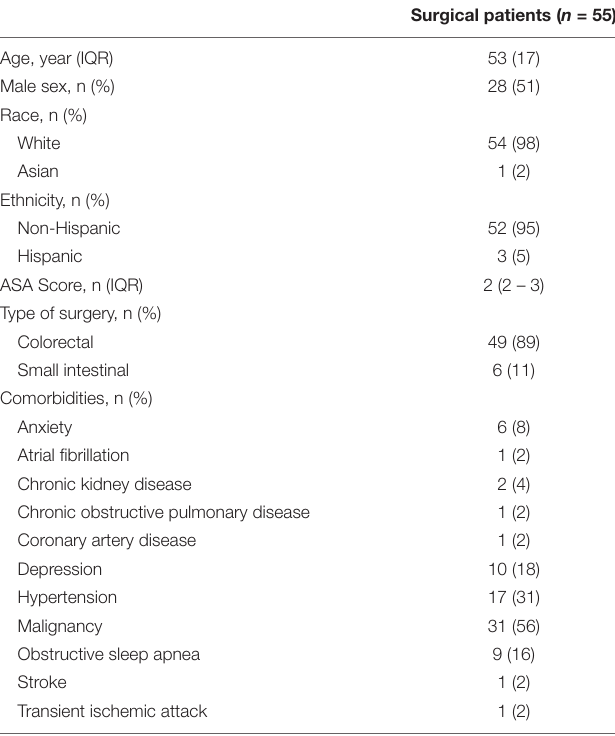
TABLE 1 | Participant characteristics are